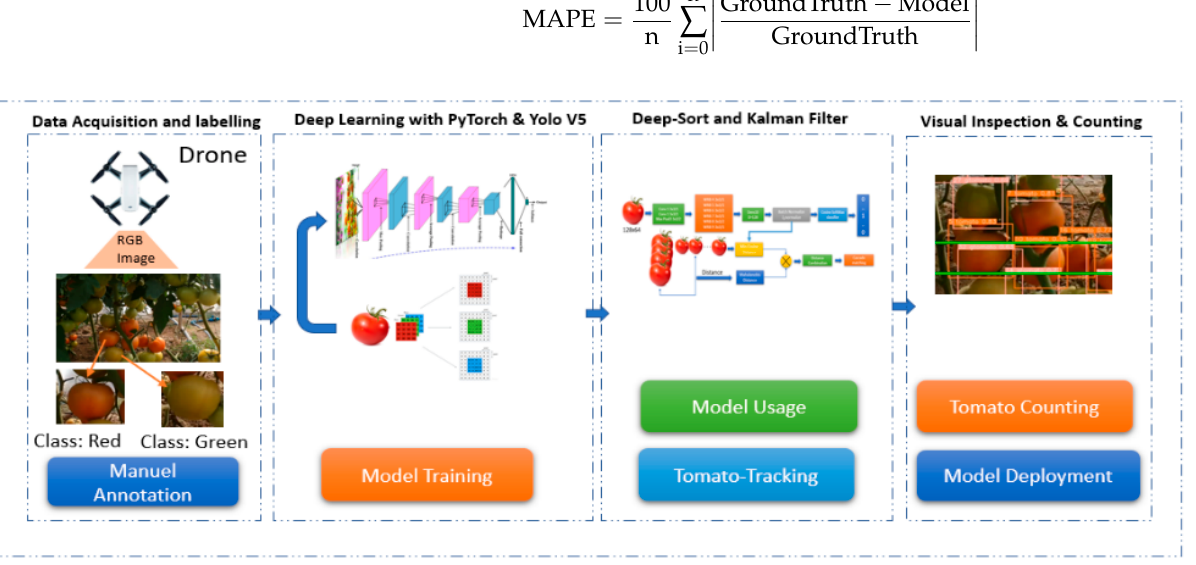
Figure 3. Methodology. Figure 3.